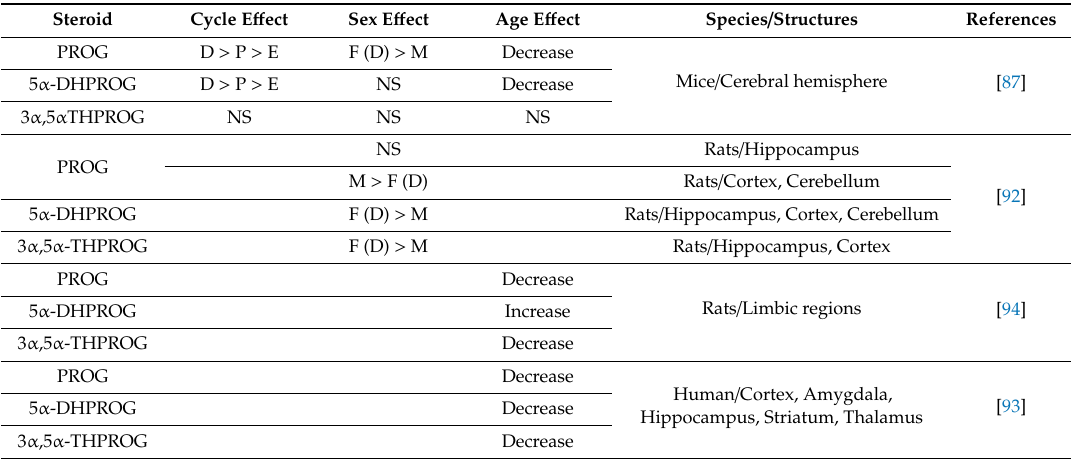
Sex e ff ect: 3-month-old male mice vs. 3-month-old female mice in diestrus stage. Age e ff ect: 20-month-old mice vs. 3-month-old mice of both sexes; 24-month-old male rats vs. 7-month-old male rats; postmenopausal (59–75